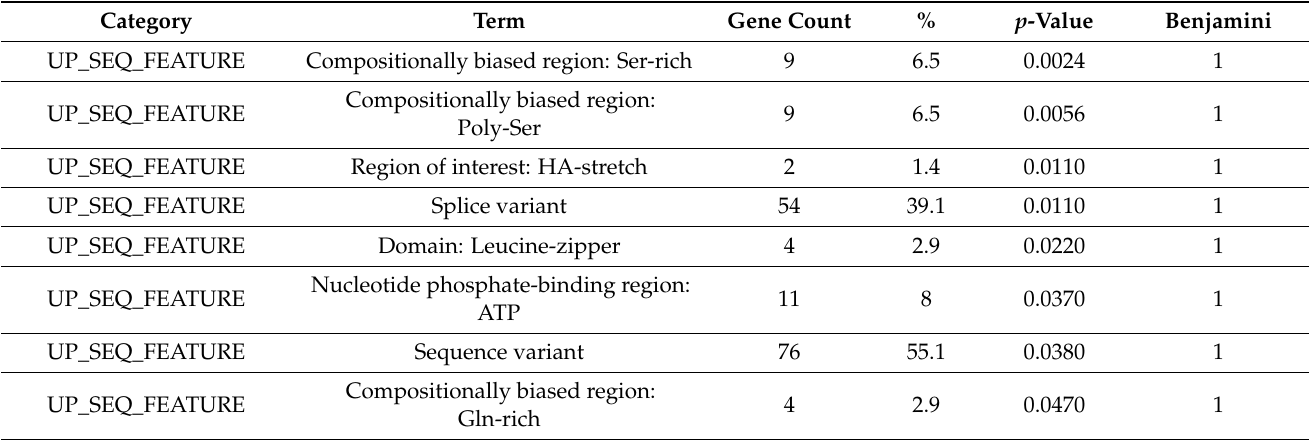
Table 3. Functional categories analysis ( p -value ≤